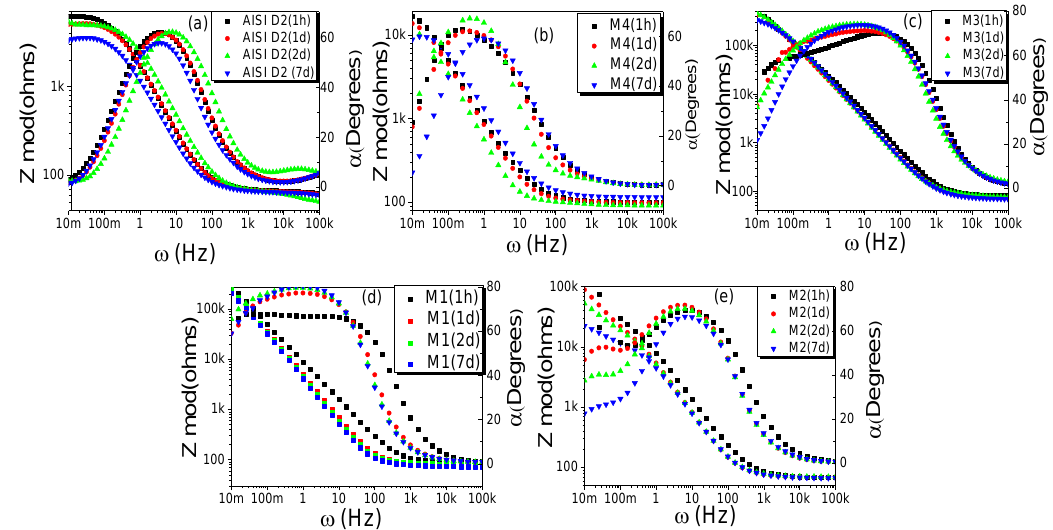
Figure 10. Bode plots for carbide coatings. ( a ) substrate; ( b ) M4; ( c ) M3; ( d ) M1; ( e ) M2.